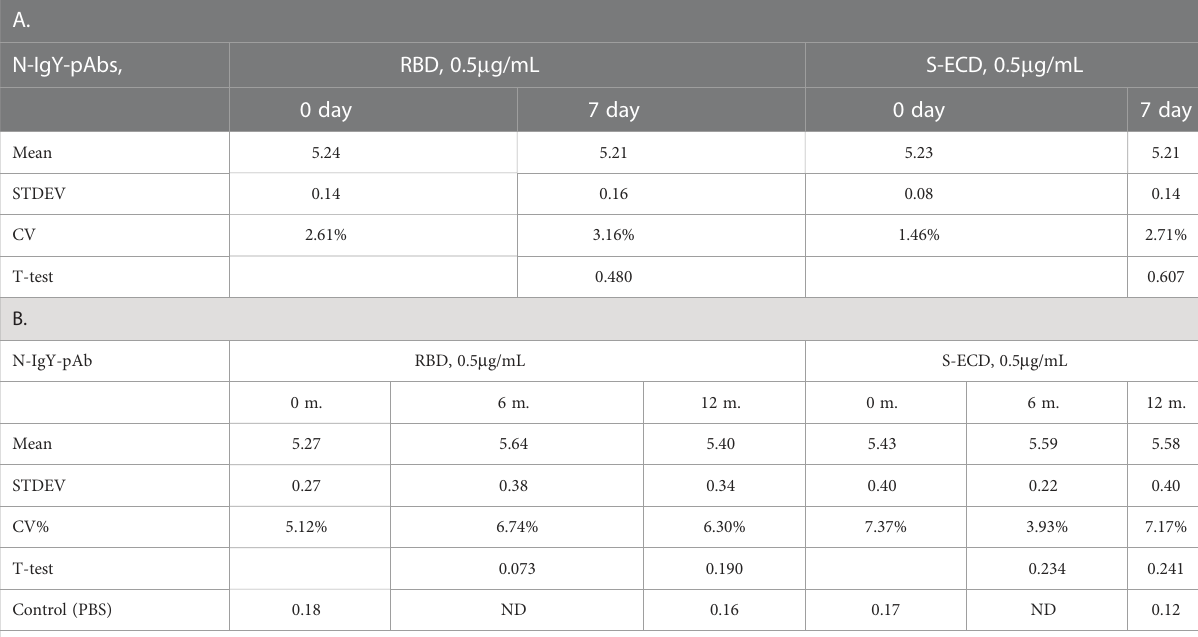
TABLE 2 The stability of the N-IgY-pAbs in spray solution for 0-7 days at 37°C (A) and 0-12 months at 4°C (B). A.